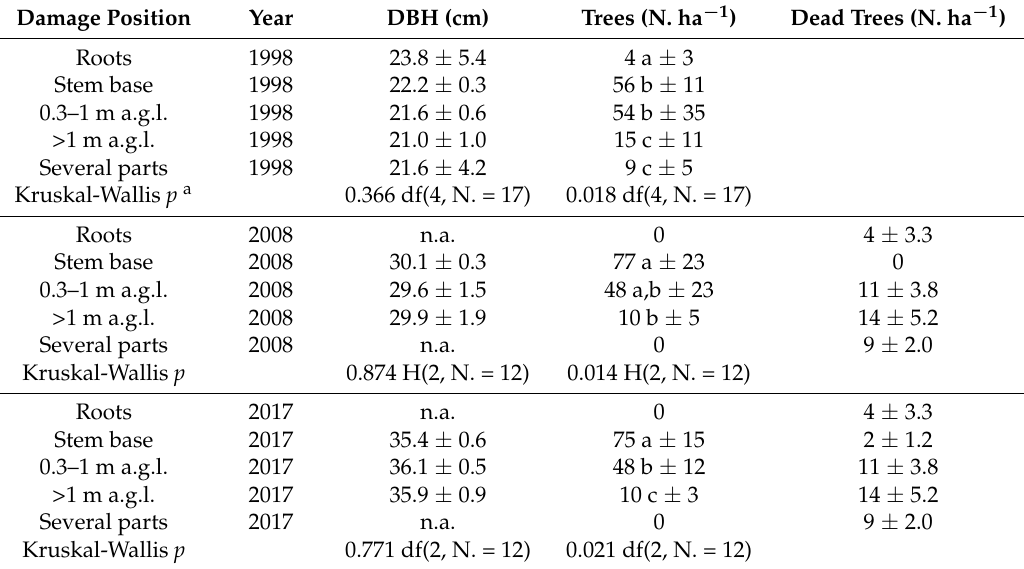
Table 5. Damage position in trees and DBH ( ± SD) after thinning in 1998, 2008, and